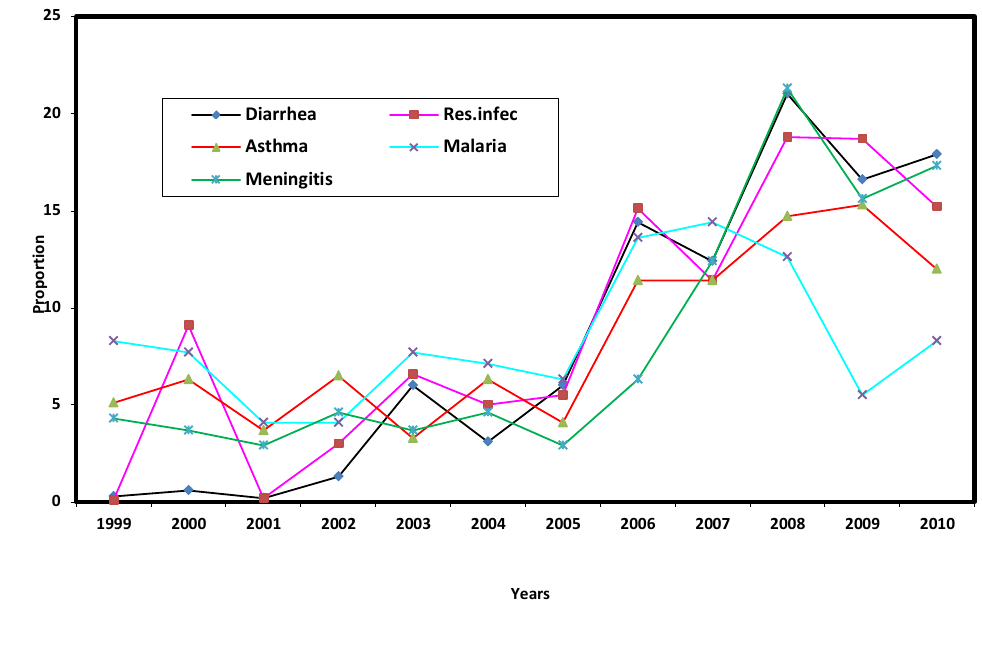
Figure 8. Trend in incidence of most prevalent diseases.